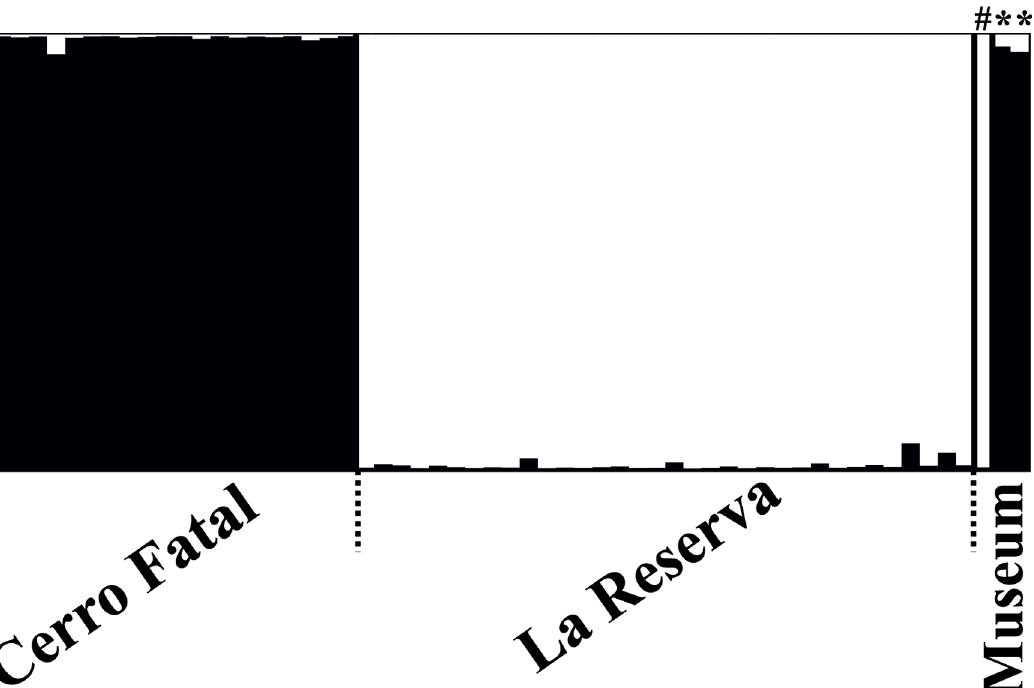
Fig 4. Genetic membership from Bayesian assignment tests in STRUCTURE for the three museum individuals, relative to the genotypic database representing the Cerro Fatal (black) and Reserva (white) giant tortoise populations. Each bar represents an individual and the proportional color of each bar represents the percentage membership (i.e., Q- value) in each of the reference clusters. Museum individuals include the C . porteri holotype (#) and the two Cerro Fatal specimens tested as putative candidates for the Chelonoidis sp. nov. holotype ( * ).